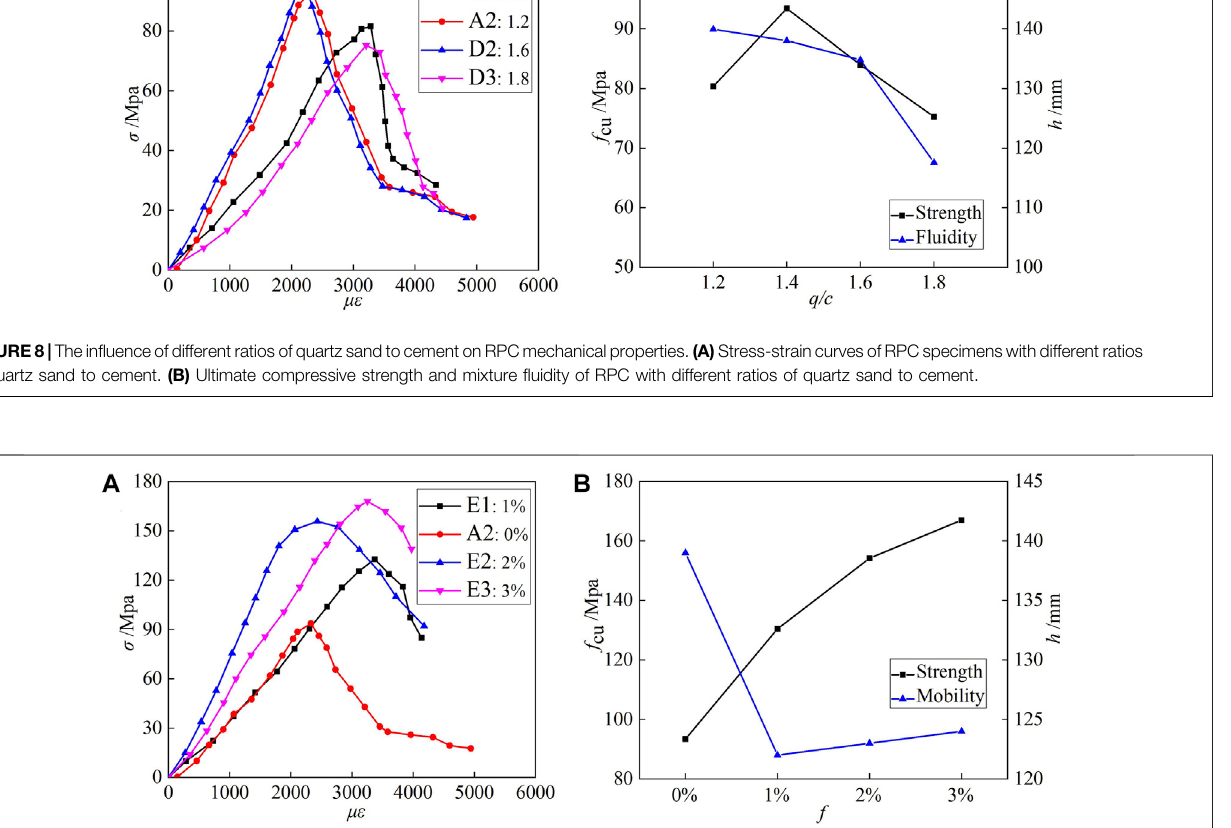
FIGURE9| Thein fl uenceofdifferentvolumefractionsofsteel fi beronRPCmechanicalproperties. (A) Stress-straincurvesofRPCspecimenswithdifferentvolume fractions of steel fi ber. (B) Ultimate compressive strength and mixture fl uidity of RPC with different volume fractions of steel fi ber.